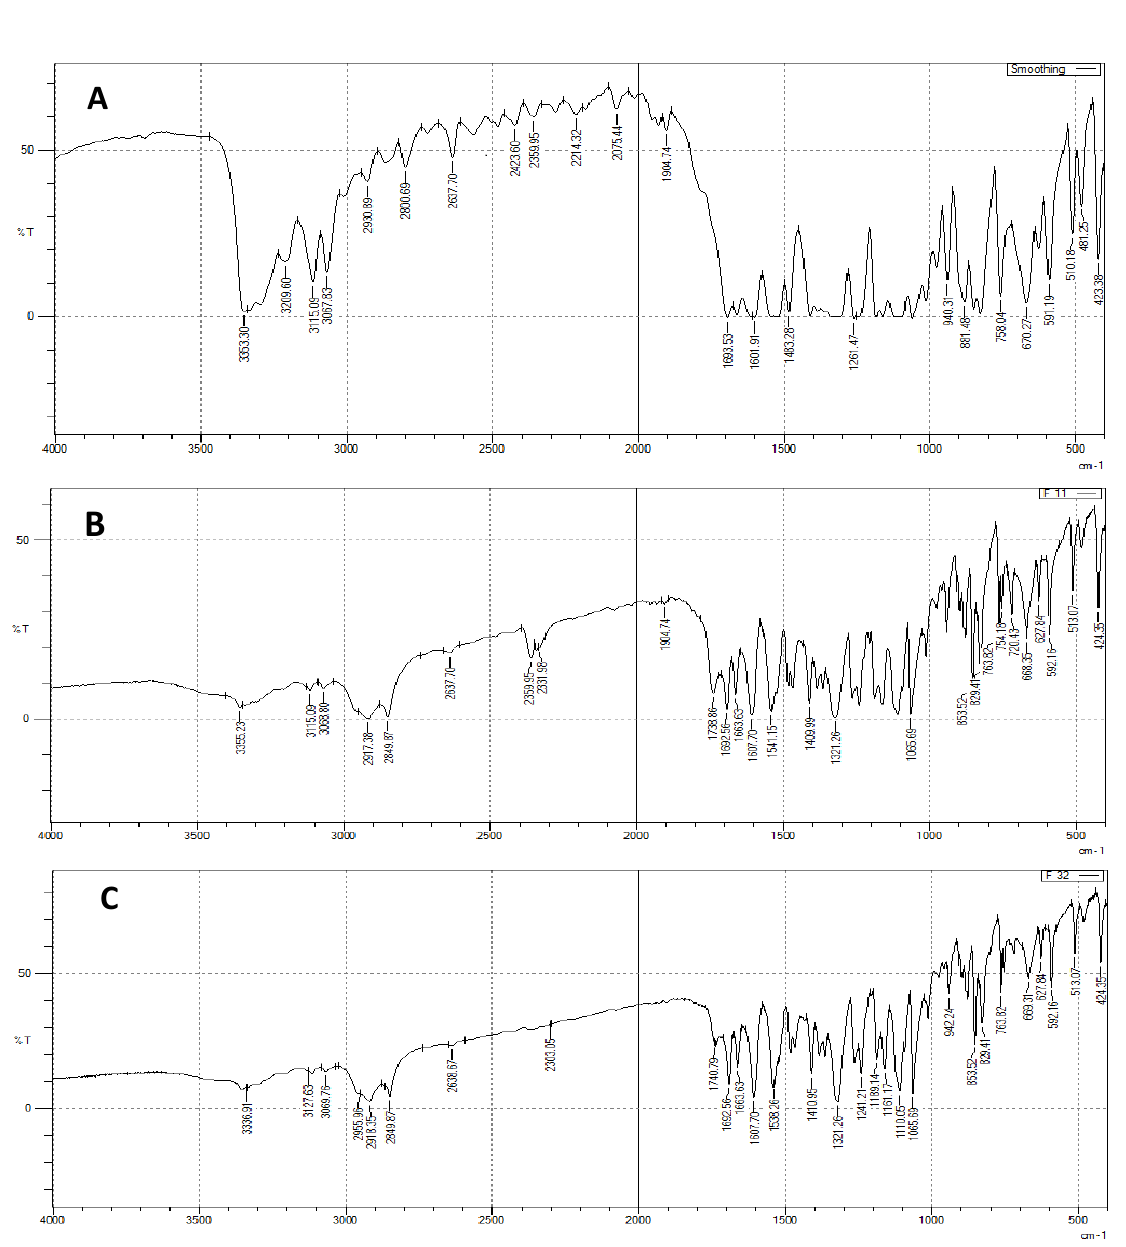
Figure 3 . FTIR spectra of: ( A ) LEF, ( B ) LEF EMLs physical mixture, and ( C ) selected EMLs formulation.